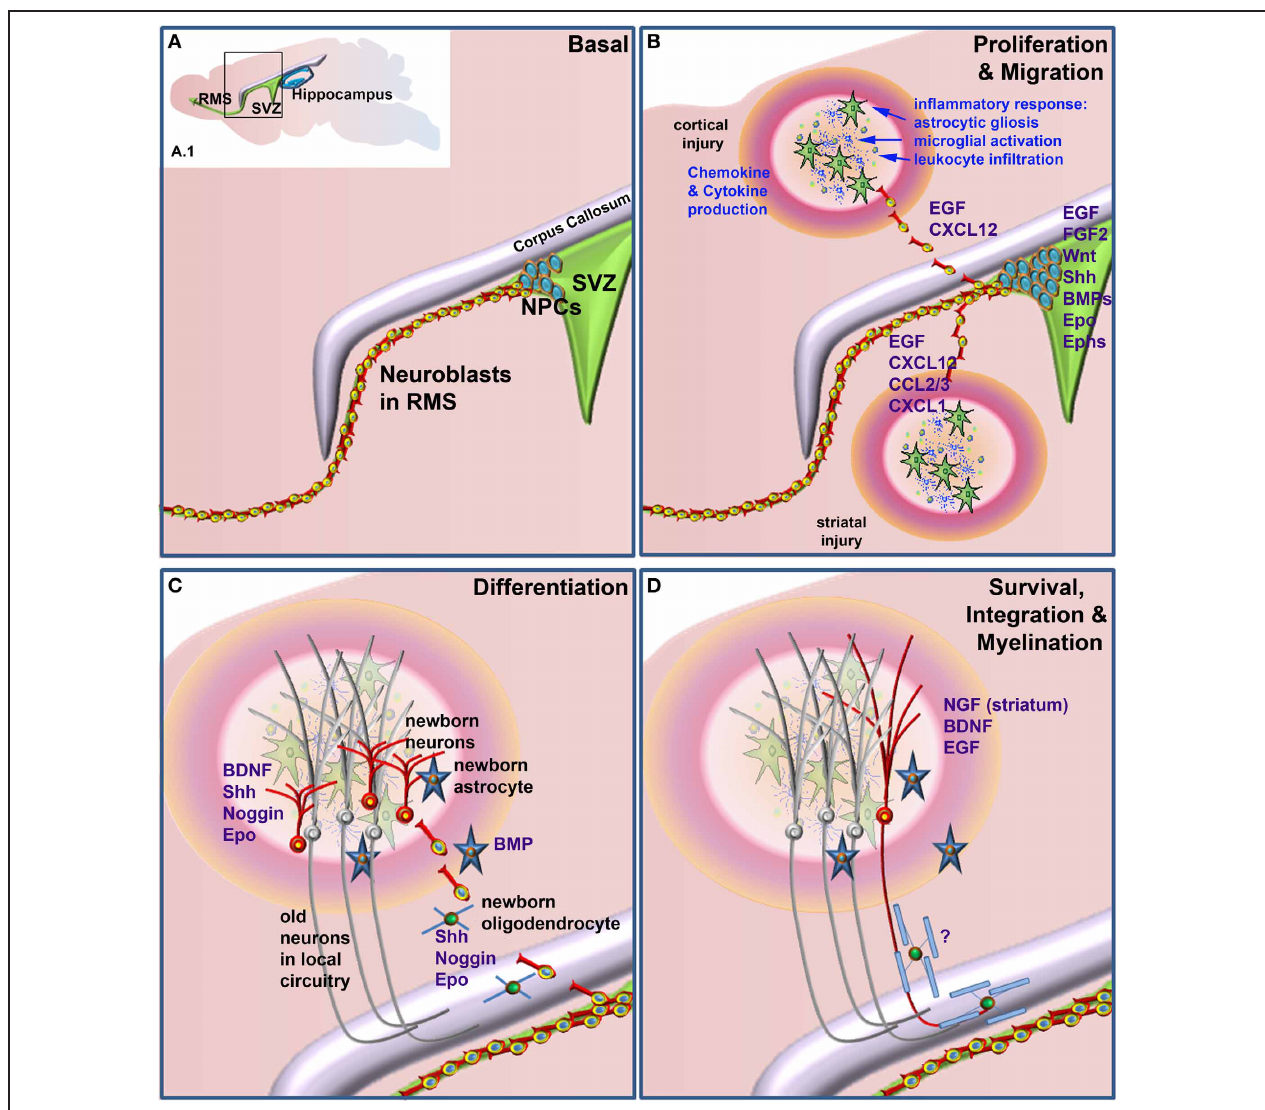
FIGURE 1 | Factors that when administered to the brain following neural damage regulate neural precursor cell responses. (A) Basal, non-damage conditions. Inset (A.1) depicts the two main neurogenic regions of the adult rodent brain, the subventricular zone (SVZ) and the hippocampus. The enlarged area bounded by the box in (A.1) depicts the general structure of the SVZ, which contains proliferative neural precursor cells (NPCs) that differentiate into neuroblasts that then migrate along the rostral migratory stream (RMS) to the olfactory bulb. Following neural injury (B) the inflammatory response induces astrocytic gliosis, microglial activation, and leukocyte infiltration from the periphery. Together, these produce a variety of chemokines, cytokines and other factors that can lead to the proliferation of the NPCs in the SVZ and redirect their migration to sites of damage. Once at or near the site of damage (C) these cells can